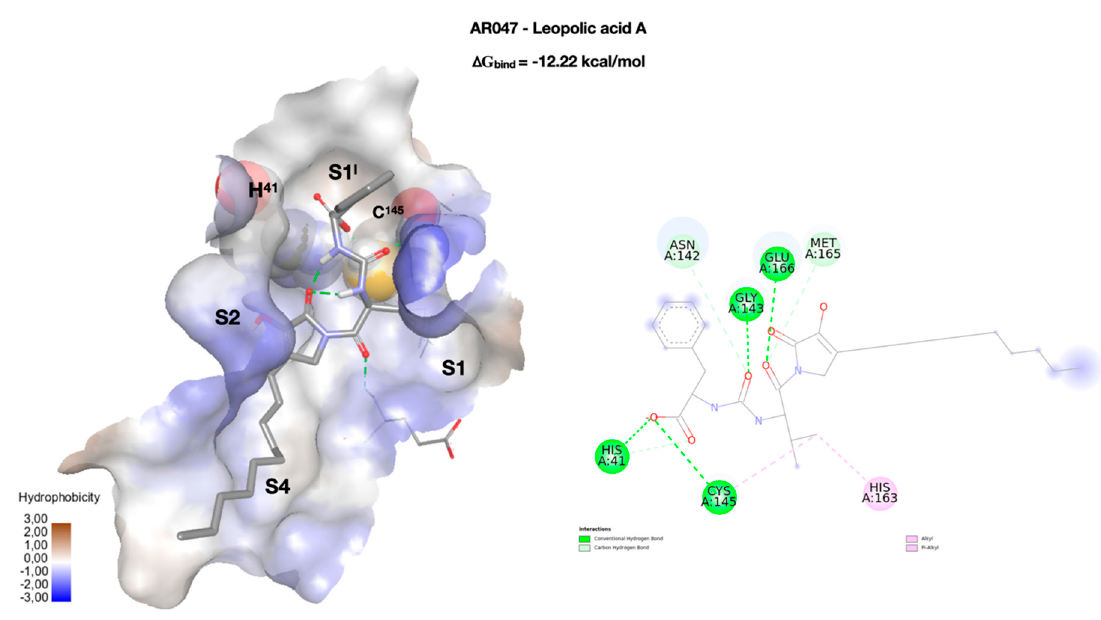
Figure 4. Docking pose of leopolic acid A (AR047) inside the enzymatic binding site, were the two key residues of the catalytic dyad (H 41 and C 145 ) are rendered in CPK. The compound is rendered in stick, while the binding site is represented as the solvent accessible surface (SAS), colored according to the hydrophobicity of the residues (wireframe). The four binding pockets (S1 I , S1, S2, and S4) occupied by the molecule are highlighted. On the right, a two-dimensional representation of the molecular interactions between the ligand and the enzyme. The colors used refer to the di ff erent interactions, as indicated in the legend.